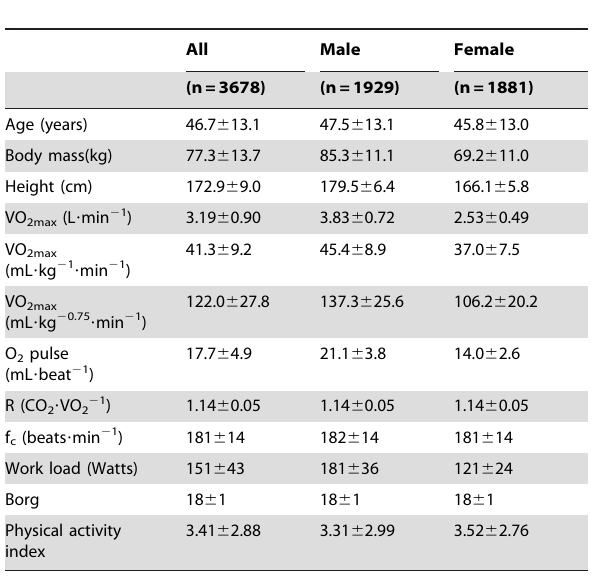
Table 1. Physical and physiological characteristics of participants in the HUNT 3 Fitness